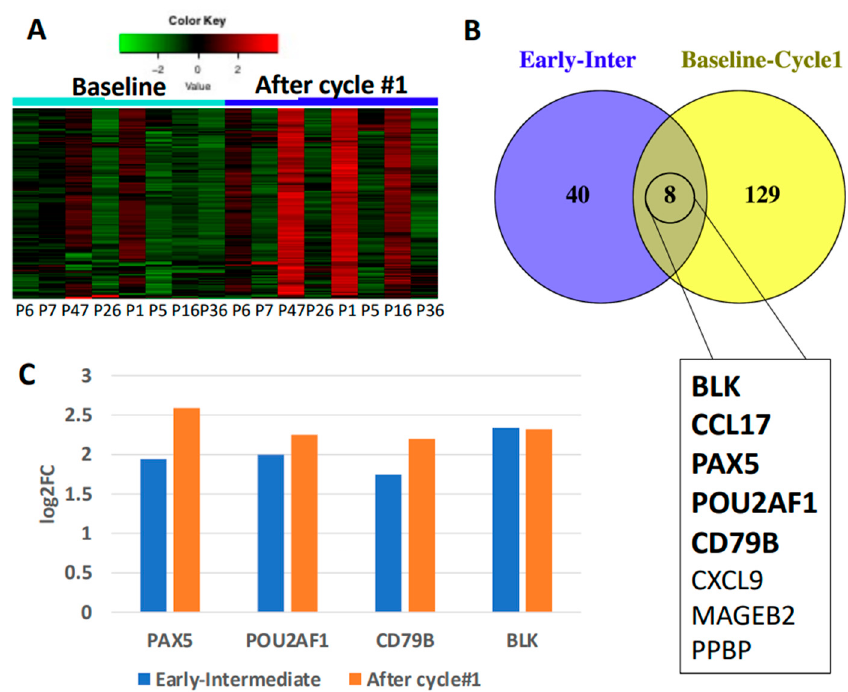
Figure 5. Immune gene expression analysis after 1 cycle of IP platinum-based chemotherapy in secondary patient cohort. ( A ) Heat map of 137 DE genes showing upregulation of 98% of genes. ( B ) 8 genes are DE in IP fluid from both patient cohorts. Bolded genes have concordant expression between both cohorts. ( C ) 4 out of 5 concordant genes are specific to B cell function, all of which are significantly upregulated in both cohorts ( p < 0.05).